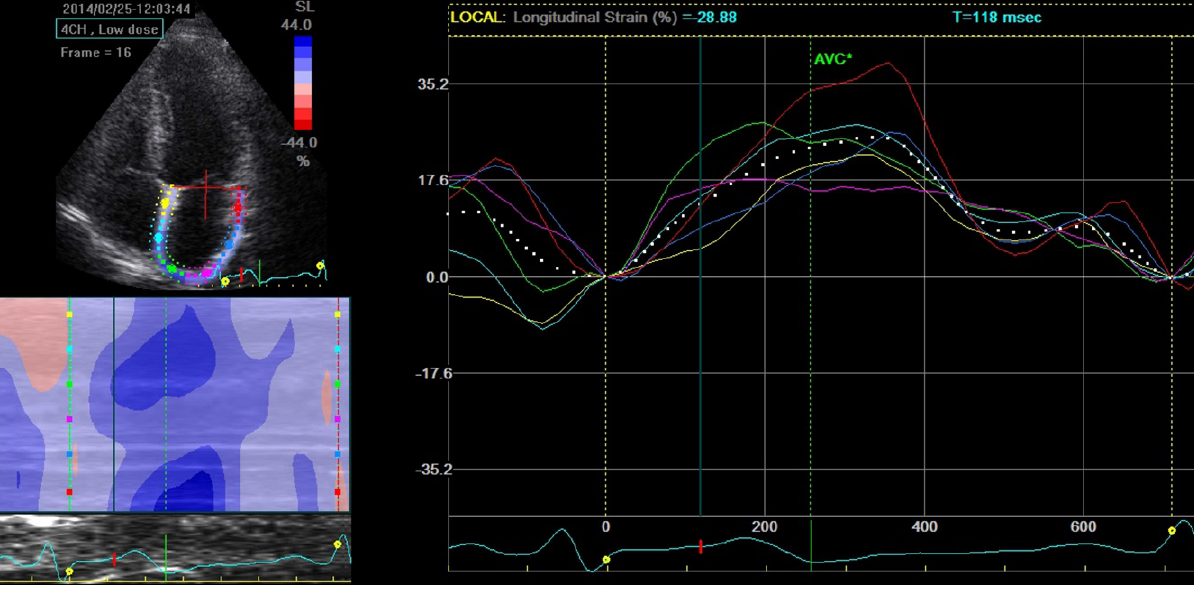
Figure 2 - Assessment of the peak atrial longitudinal strain by two-dimensional speckle-tracking echocardiography. The dashed curve represents the average atrial longitudinal strain along the cardiac